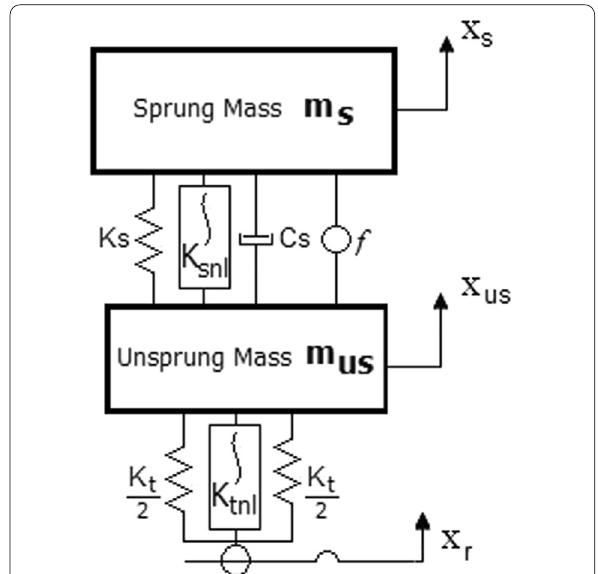
Fig. 1 Nonlinear quarter car—active suspension